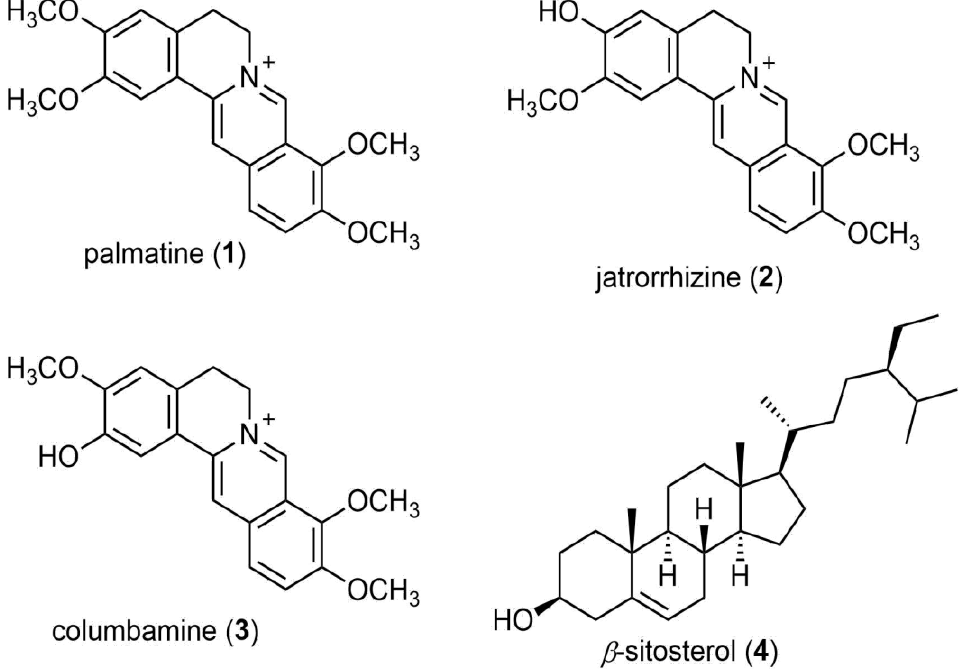
Figure 1. Chemical structures of the isolated compounds.